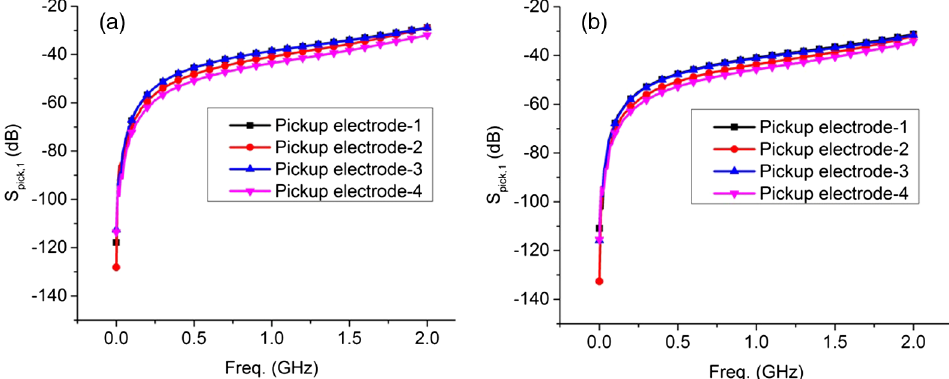
FIG. 12. S-parameters (S ) of IDBPI measured using the modified coaxial wire method. (a) 1.5 mm wire diameter and (b) 0.6 mm pick ; 1 wire diameter.